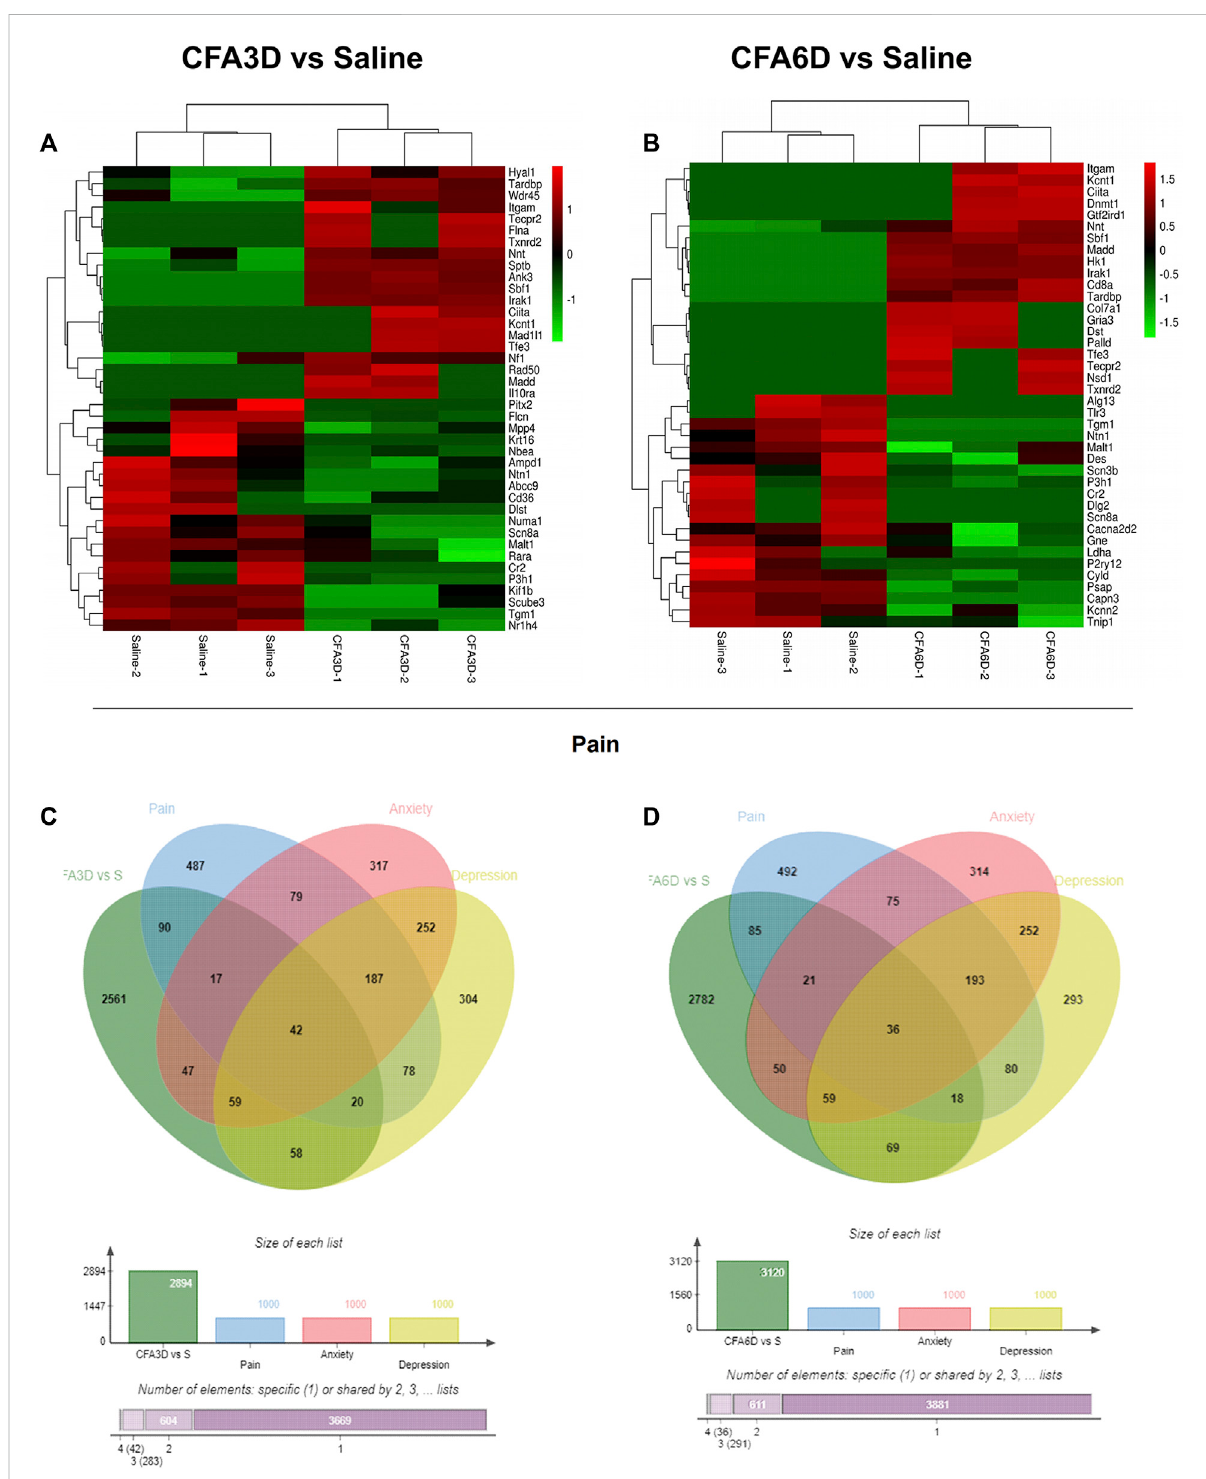
FIGURE 8 Comparisons of pain-, anxiety-, and depression-related genes in the TG of temporomandibular joint disorder (TMD) mice. (A,B) heatmaps of representativetop20upregulatedanddownregulatedpain-relatedDEGsonCFA3D (A) andCFA6D (B) afterTMD. (C,D) Venndiagramsindicatedthe number of overlapped pain-, anxiety-, and depression-related DEGs in the TG on CFA3D (C) and CFA6D (D) after TMD. Colors in the heatmaps indicate the row Z-score among the different datasets. Upregulated and downregulated genes are colored in red and green,